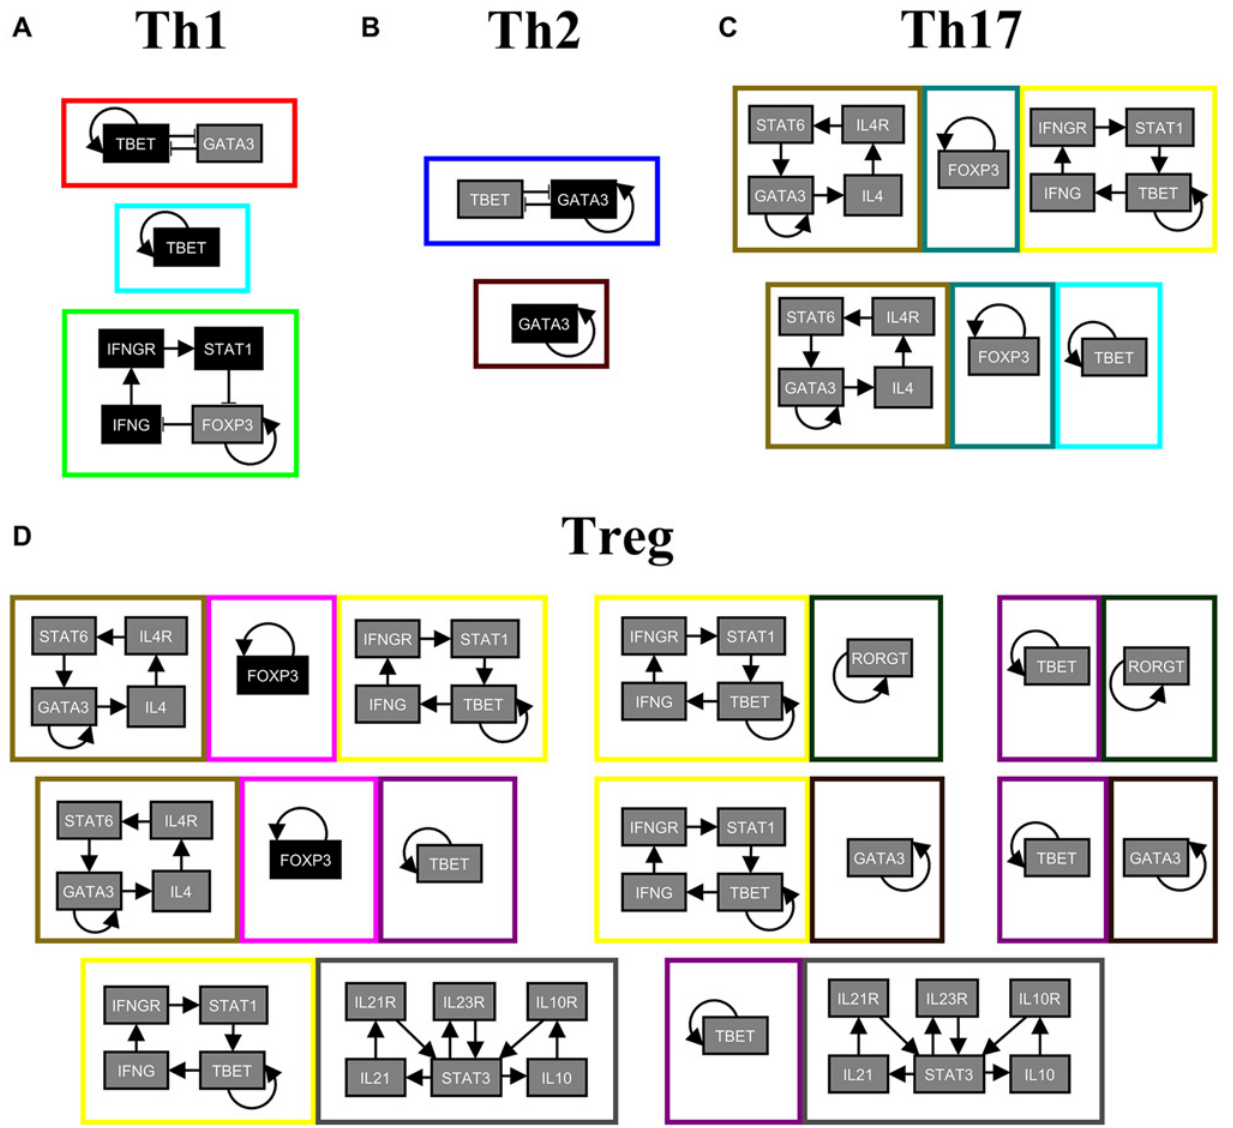
Fig 6. Minimal subsets of stable motifs associated to each helper T cell subtype. Each stable motif is enclosed by a colored rectangle, and motifs which are part of the same minimal subset have their enclosing rectangles touching each other. The node colors denotes their respective node states in the stable motifs: gray for 0 and black for 1. The color of the rectangle enclosing each stable motif corresponds to the respective color of that motif in Fig 5.